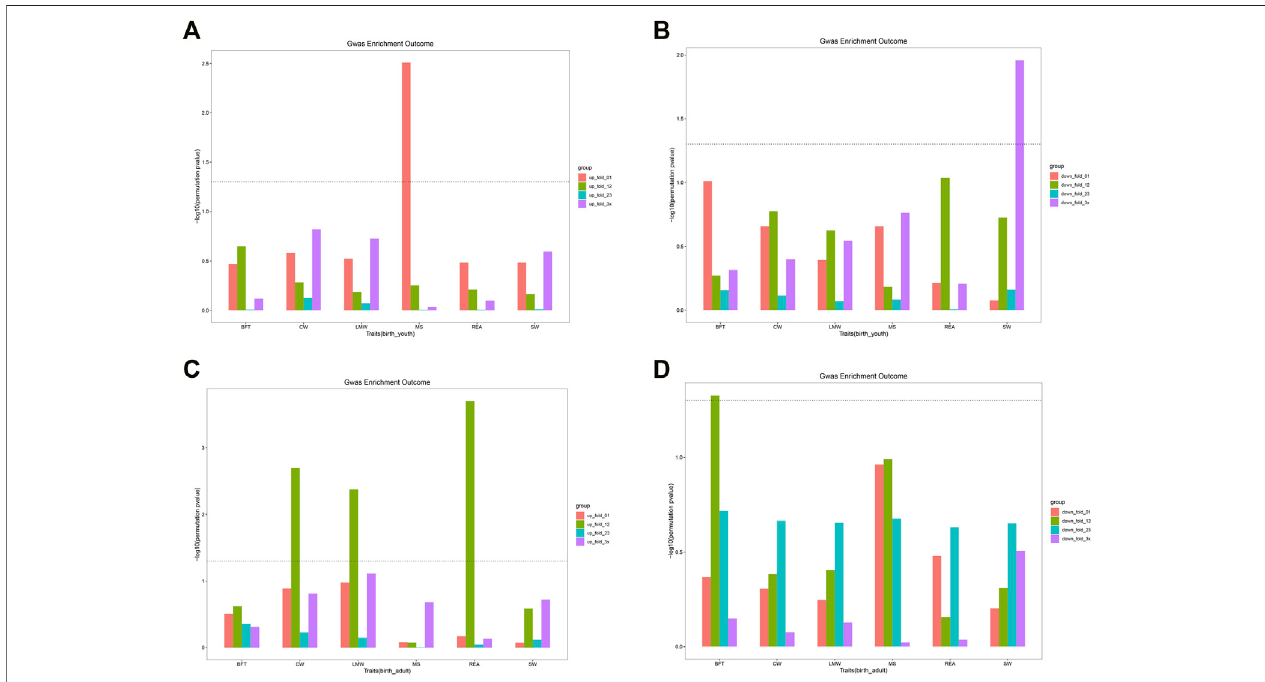
FIGURE5 | TheGWAS enrichmentfor DEGs in different groups. (A) The enrichment forDEGs of four groups in birth vs youth. (B) The enrichment for DEGs offour groups in birth vs youth. (C) The enrichment for DEGs of four groups in birth vs adult. (D) The enrichment for DEGs of four groups in birth vs adult. The line means P is equal to